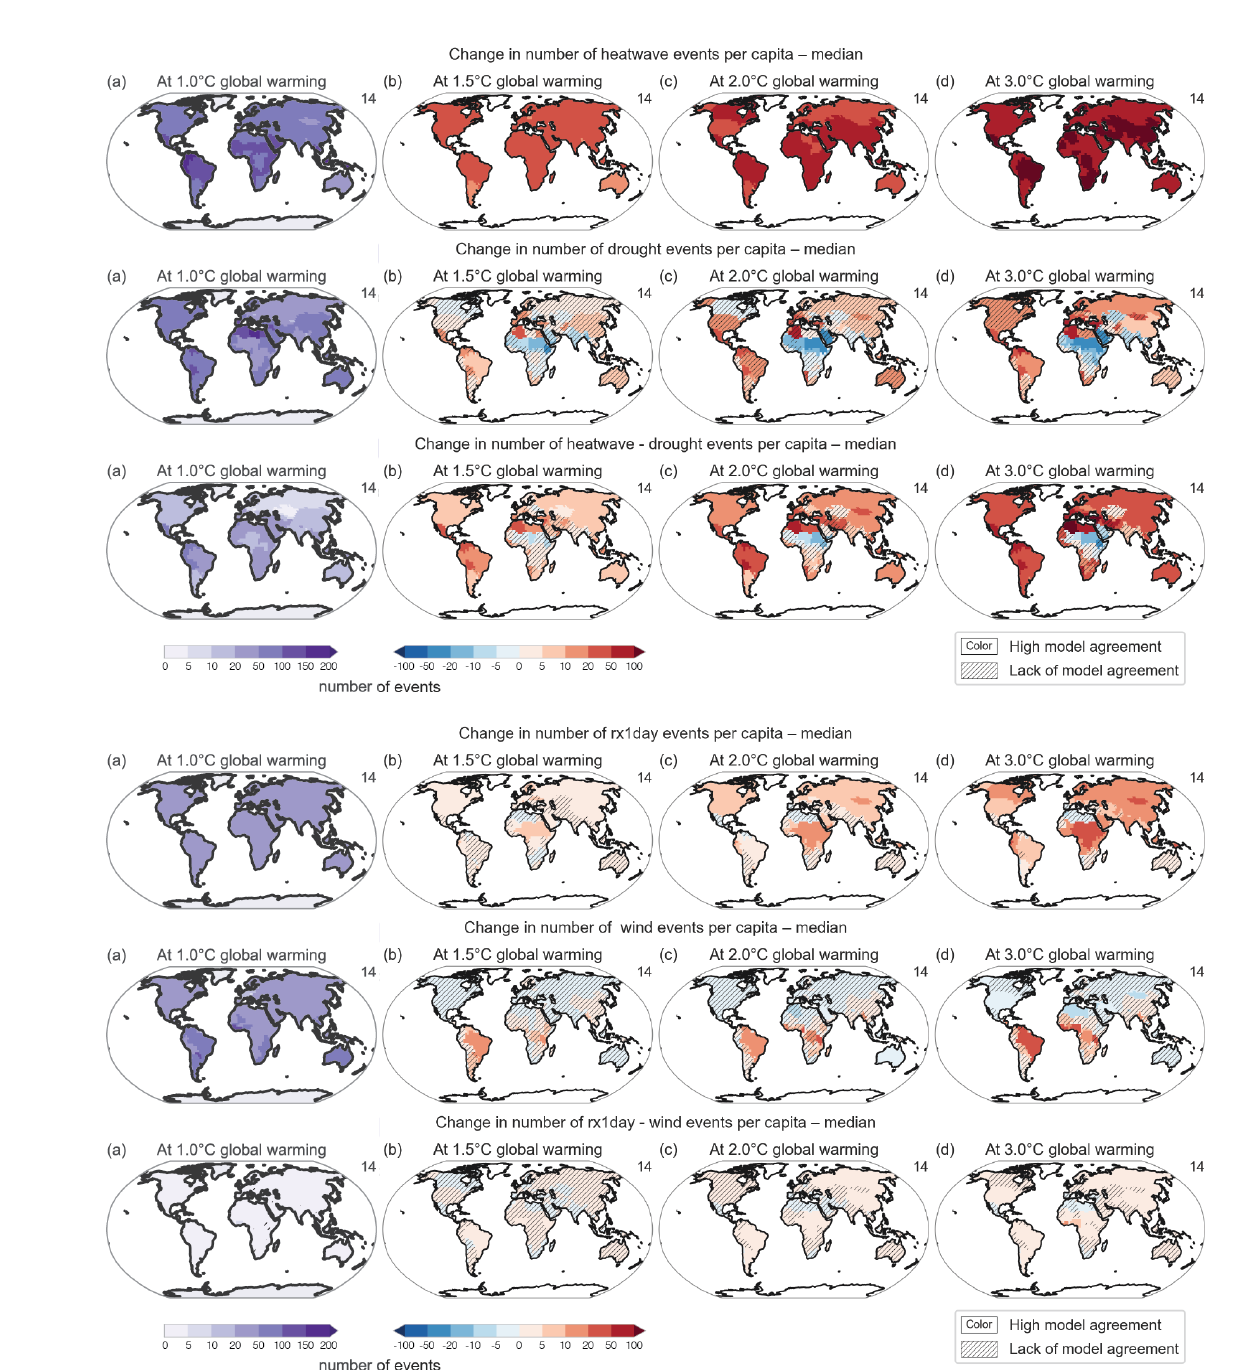
Figure 7. Number of individual and concurrent extremes per capita (a) at + 1 ◦ C and (b, c, d) change at + 1.5, + 2 and + 3 ◦ C with respect to + 1 ◦ C. Population counts for 2015 have been used for the analysis. Colours refer to high model agreement, and hatched areas refer to lack of model